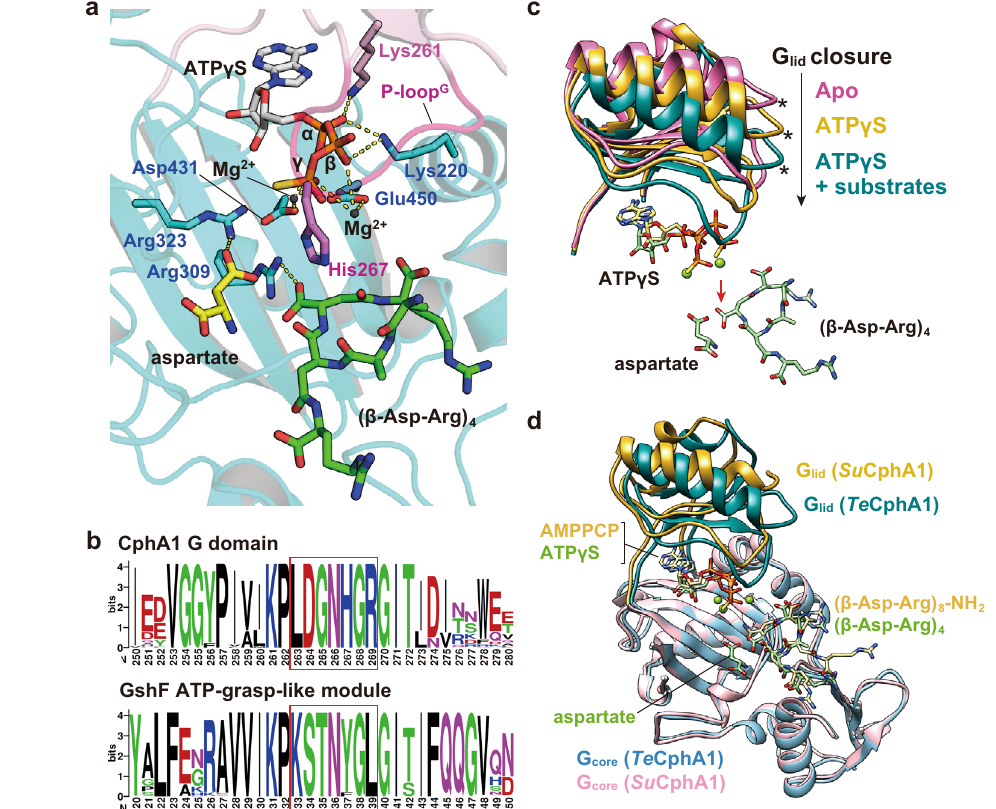
Fig. 3 | G lid movement dependent on the binding of ATP and substrates, aspartate and ( β -Asp-Arg) 4 . a Residue arrangement around ATP γ S, the substrate aspartate, and the C-terminal backbone carboxy group of ( β -Asp-Arg) 4 . Hydrogen bonds and Mg 2+ coordination are shown as yellow dashed lines. b Sequence logo depicting different conservedmotifs between the P-loop G of CphA1and the P-loop of the GshF ATP-grasp-like module. The P-loop sequences are shown in red boxes. The numbers under the logo correspond to the residue numbers of Te CphA1 and